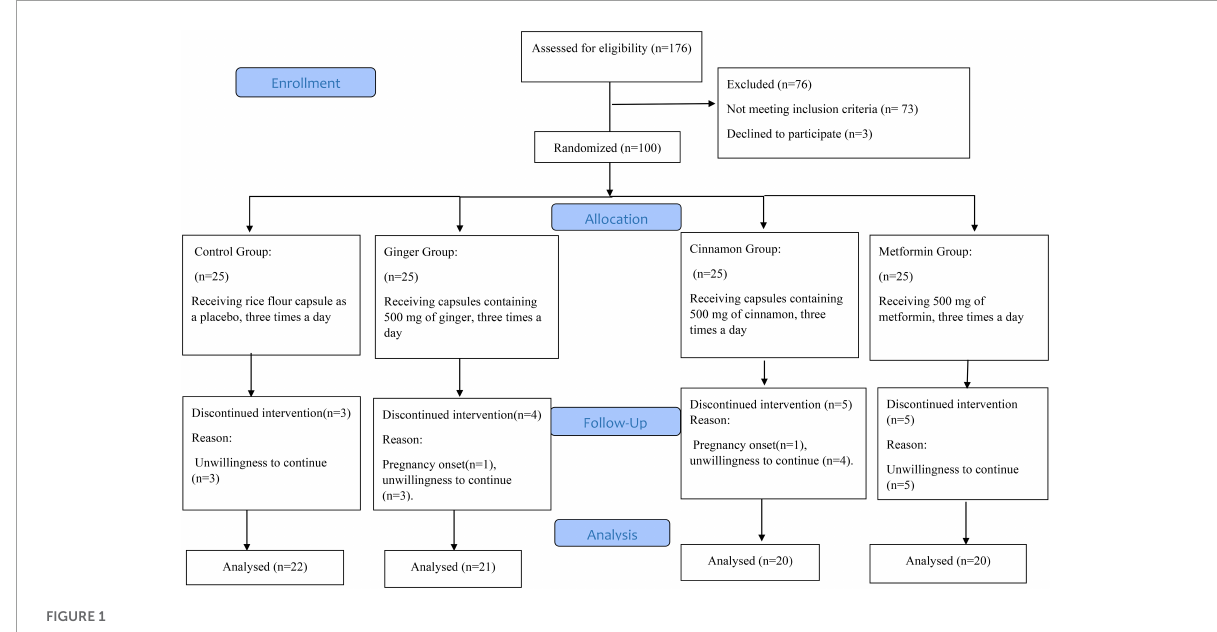
FIGURE1 The CONSORT flow